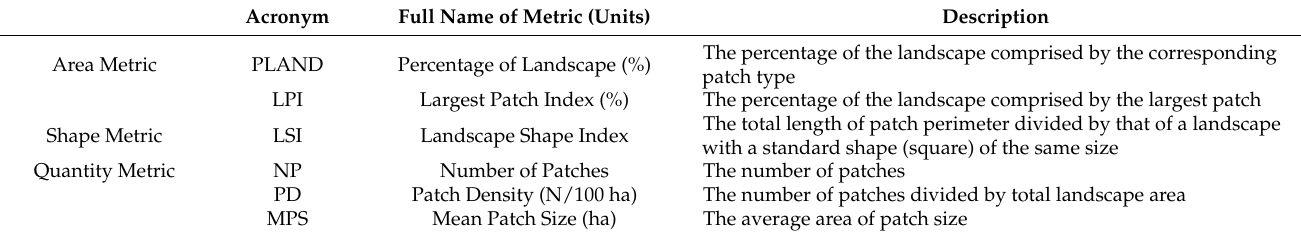
Table 4. Landscape metrics used in this study, adopted from McGarigal